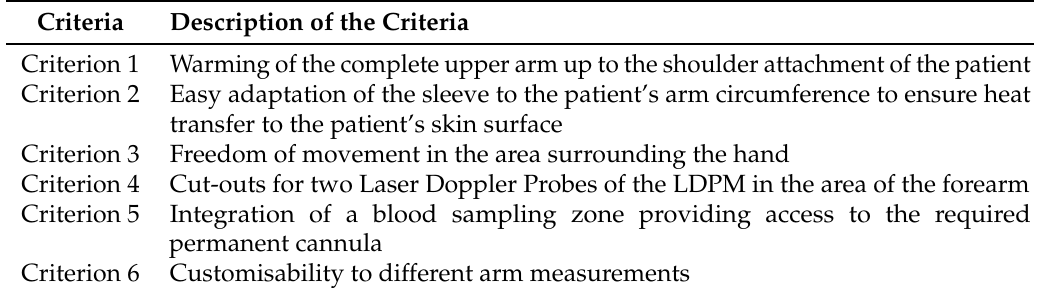
Table 1. The criteria for the design of the